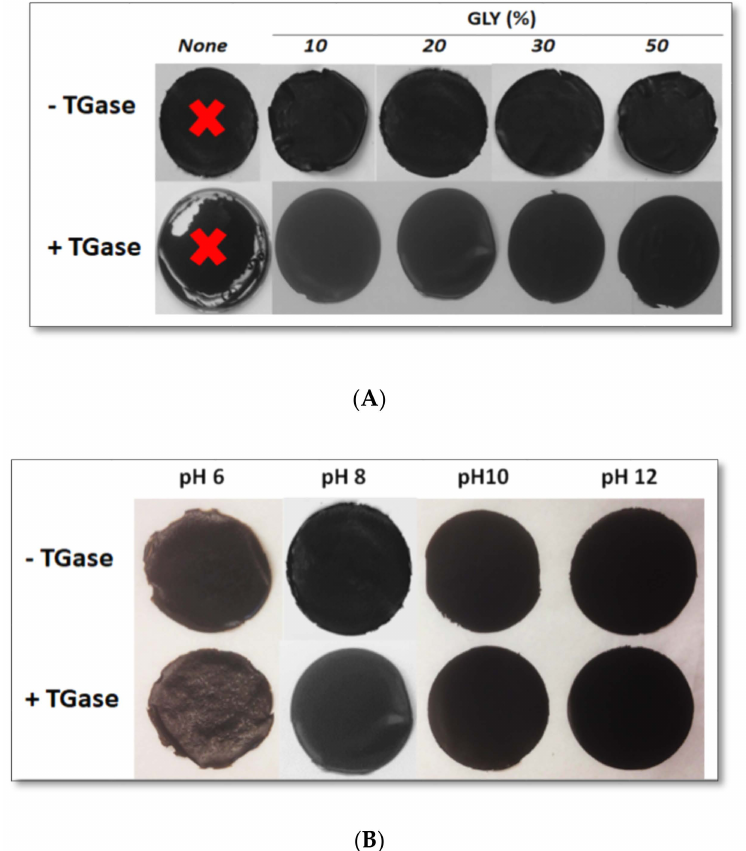
Figure 4. Images of protein concentrate (PC, 400 mg) films either containing di ff erent concentrations of glycerol (GLY) and obtained at pH 8.0 ( A ) or containing 20% GLY and obtained at di ff erent pH values ( B ) after incubation of the FFSs in the absence or presence of transglutaminase (TGase, 20 U / g protein). Further experimental details are given in the